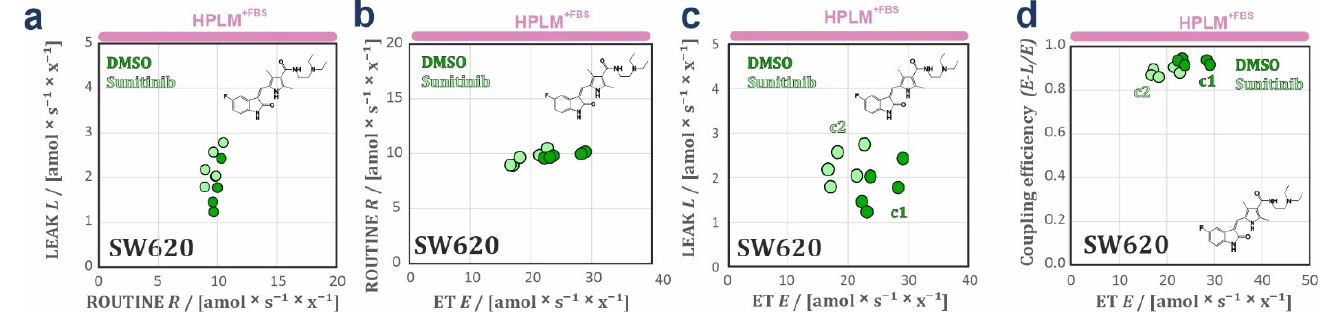
Figure 6. Bioenergetic cluster analyses in different respiratory coupling states of the sunitinib-exposed SW620 cells. Plots of L over R , R over E , and L over E . ( a – c ) SW620 cells grown in HPLM +FBS and exposed to either DMSO or 10 µM sunitinib for 3 h. In this case, two heterolinear clusters (c1, DMSO and c2, sunitinib) were detected when L is plotted over E , one with higher L when E is decreasing (c2) indicating dyscoupling induced by sunitinib. ( c ) Coupling efficiencies ( E-L )/ E over ET capacities in SW620 cells grown HPLM +FBS ( d ), and exposed to either DMSO or 10 µM sunitinib for 3 h. The two clusters, one with lower (E-L)/E values in cells grown in HPLM +FBS and exposed to sunitinib (c2) indicates a drop in mitochondrial quality with the sunitinib treatment. Sunitinib chemical structure is depicted for drug-exposed SW620 cells ( a – d ).